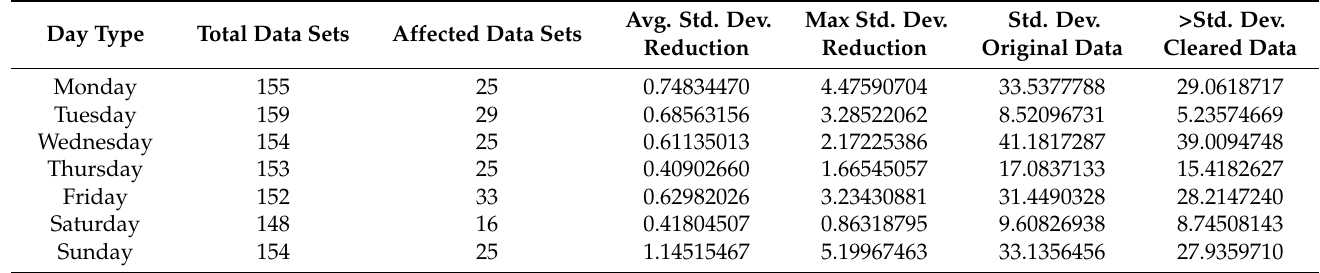
Table 17. Semester II baseline for original and cleared data sets. Table 15. Full year baseline for original and cleared data sets.